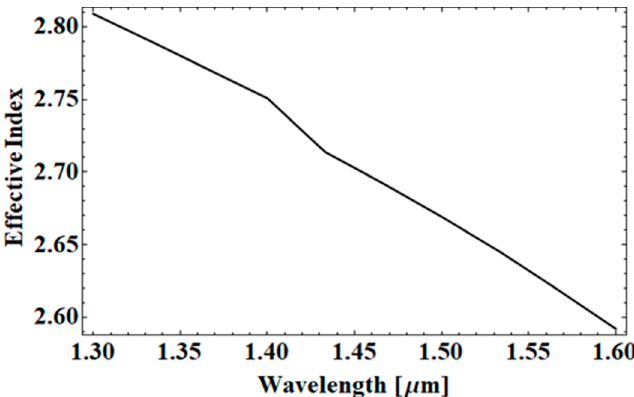
Figure 8. Effective index as a function of wavelength. Figure 8. E ff ective index as a function of